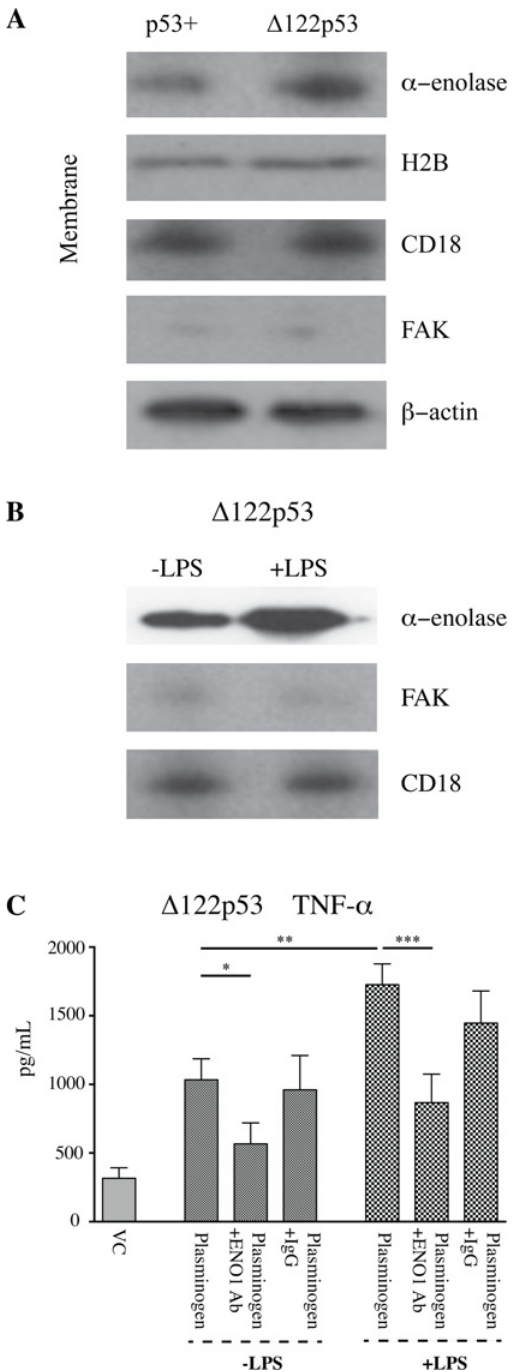
Figure 3. Increased α -enolase function on the Δ 122p53 cell membrane. A. Alpha-enolase was not the only plasminogen receptor increased on the Δ 122p53 cell membrane. The cell membrane and cytosolic fractions of untreated PBMCs from p53+ and Δ 122p53 mice were separated and subjected to western blotting with an antibody to histone H2B and alpha-enolase. β -actin, FAK, and CD18 were used as loading controls for total protein, cytosolic, and cell membrane fractions, respectively. B. LPS was added to enhance the amount of alpha-enolase on the Δ 122p53 PBMCs cell membrane. The cell membrane and cytosolic fractions of untreated Δ 122p53 PBMCs or those incubated with LPS (5 μ g/mL for 6 hours) were separated and subjected to western blotting with an antibody to alpha-enolase. FAK and CD18 were used as loading